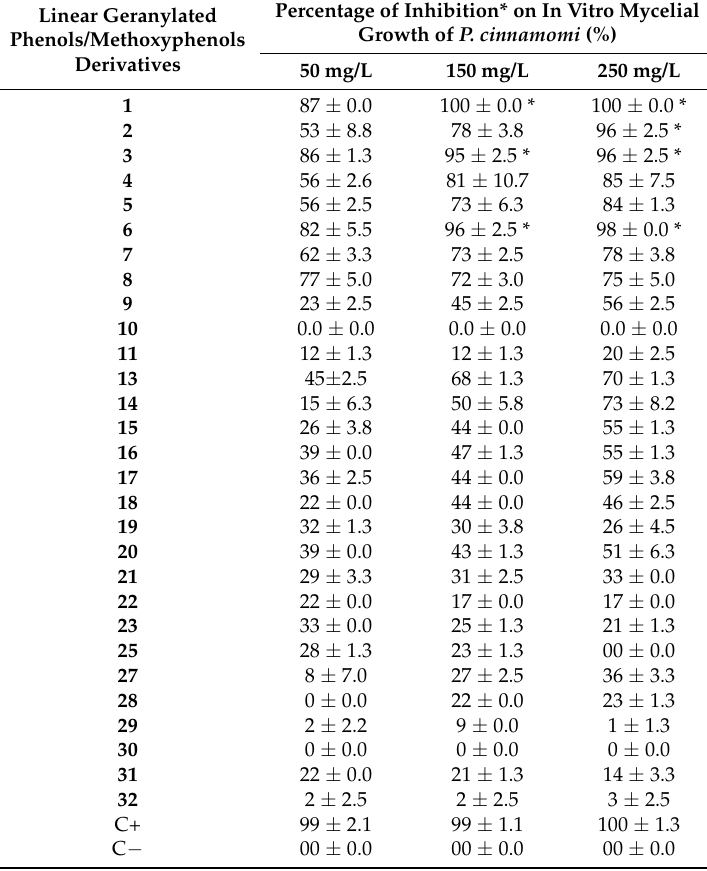
Table 1. Effect of linear geranylated phenol/methoxyphenol derivatives on the in vitro mycelial growth of P. cinnamomi , measured as a percentage of